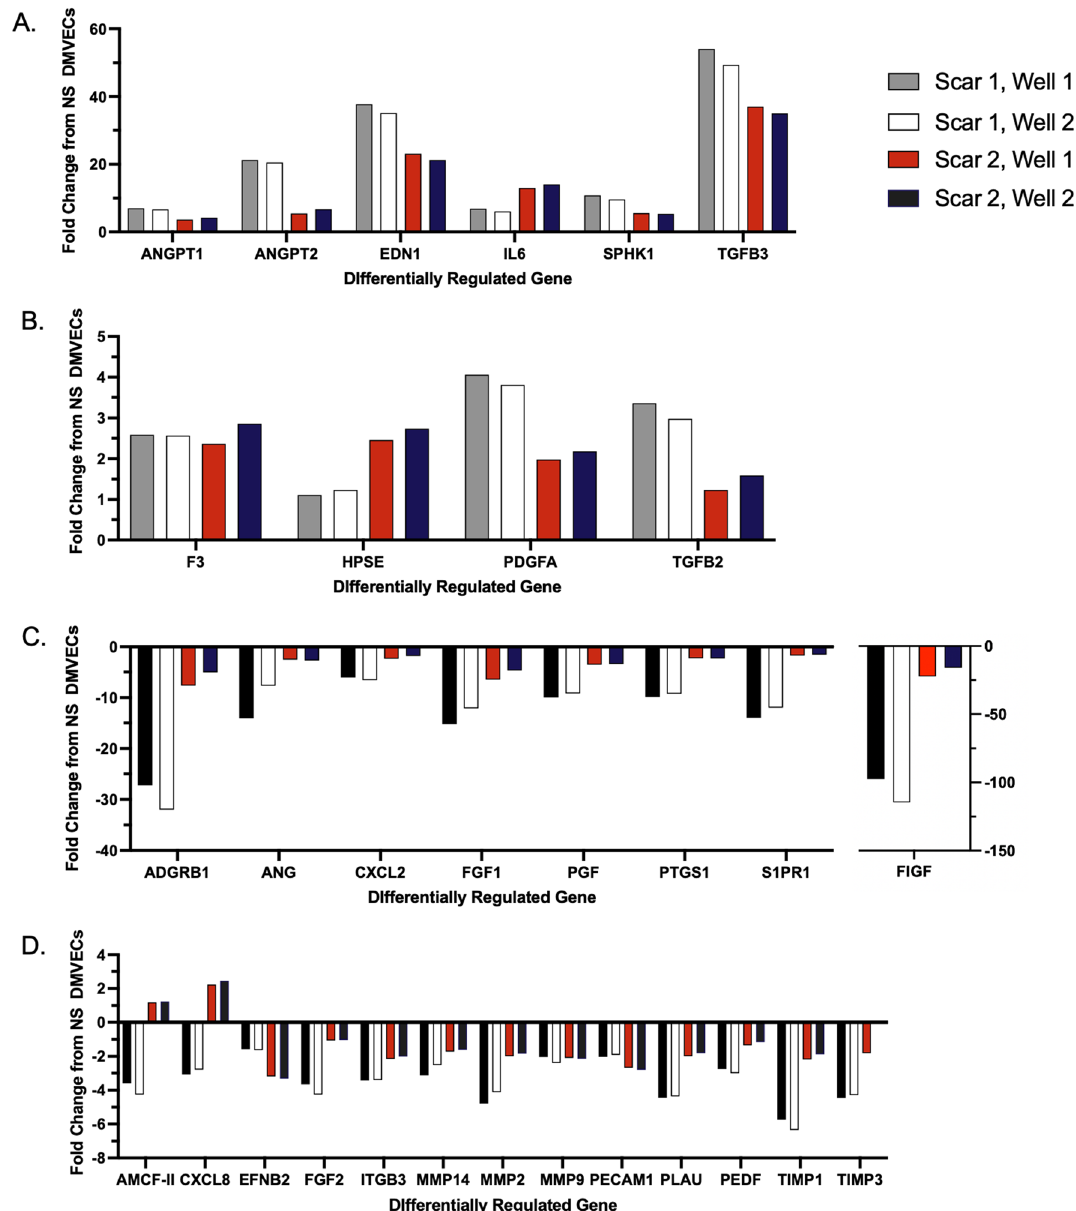
Figure 5. DMVECs from burn HTS differentially express 31 out of 84 genes relative to NS DMVECs. PCR array measured mRNA expression between burn HTS and NS DMVECs. Gene expression upregulated greater than 5-fold in HTS versus NS ( A ), gene expression upregulated less than 5-fold in burn HTS versus NS ( B ), gene expression downregulated greater than -5-fold in burn HTS versus NS ( C ), and gene expression downregulated less than -5-fold in HTS versus NS ( D